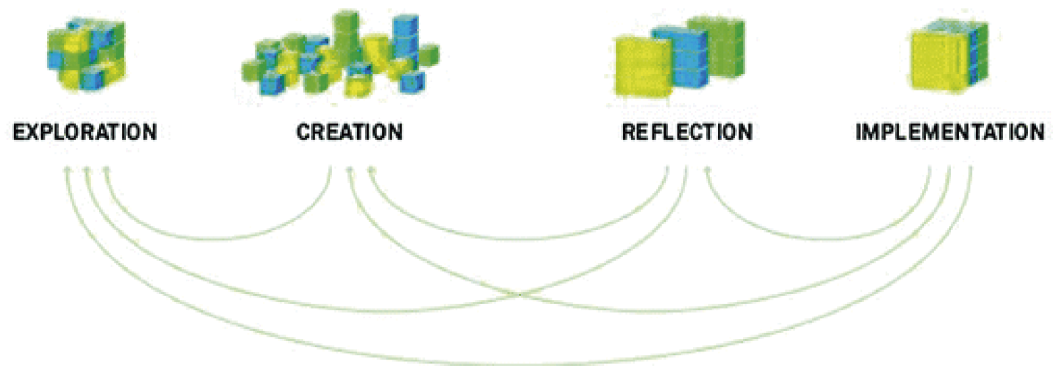
Figure 1. Service Design Thinking